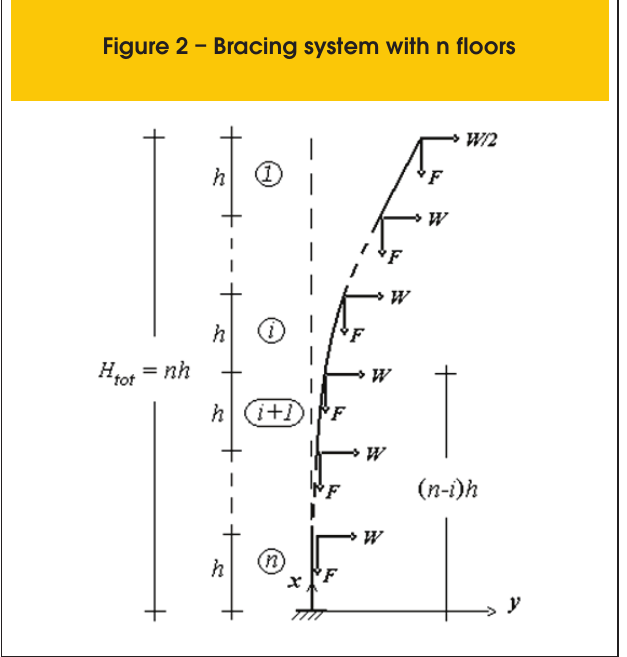
Figure 2 – Bracing system with n